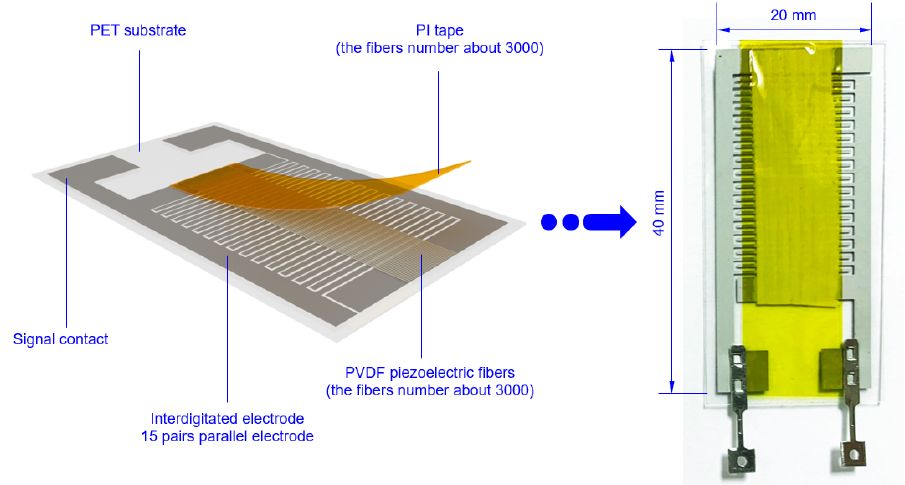
Figure 2. Schematic diagram of the interdigitated (IDT) electrode. Table 1. Technical data of silver paste